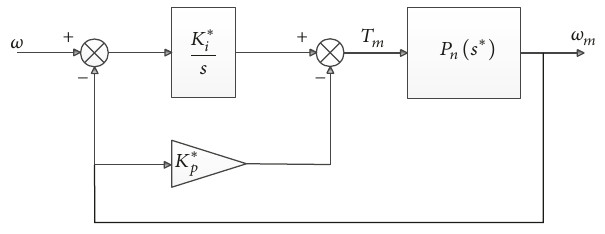
Figure 5: Block diagram of the closed-loop